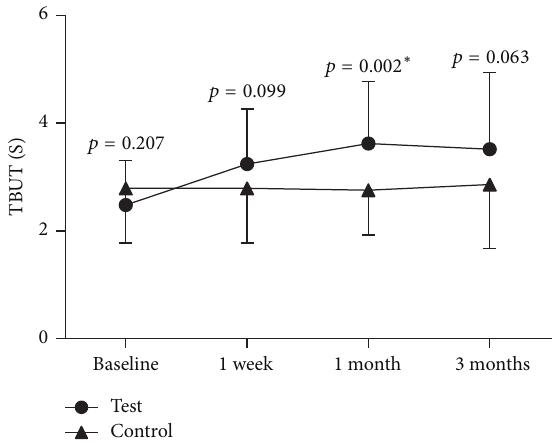
Figure 9: Time course of tear film breakup time (TBUT). Circle: test eye; triangle: control eye. There was a significant change between the test and control eye ( 𝑝 = 0.045 ). Differences of each point (one week, one month, and three months) posttreatment visit were labeled above the line ( ∗ 𝑝 < 0.05 ).